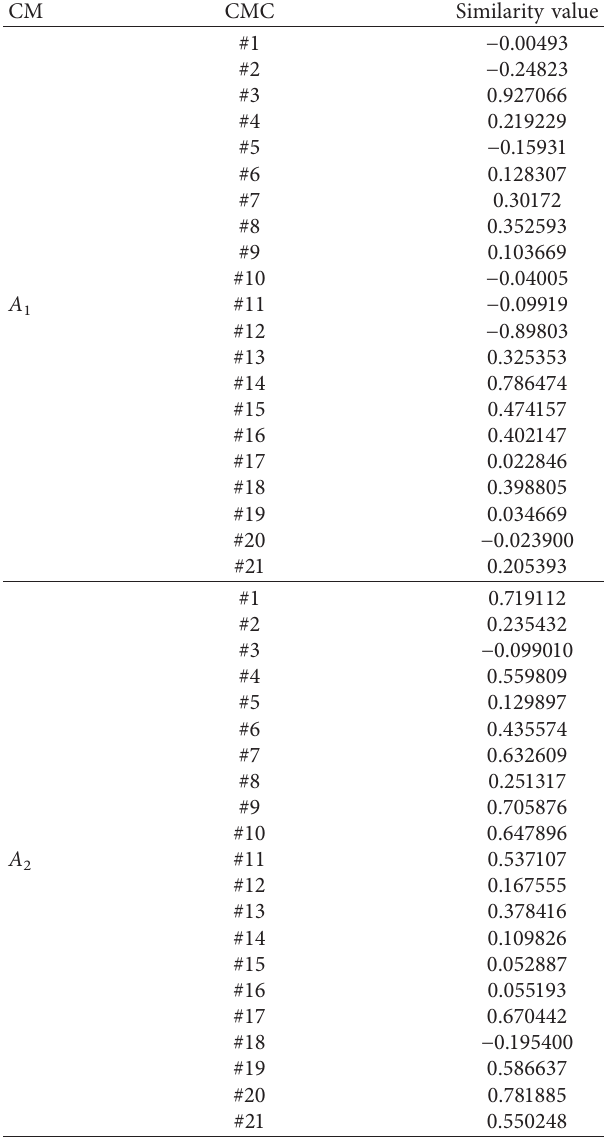
Table 2: Similarity between considered company A non-FFS candidate matching companies #1–#21.